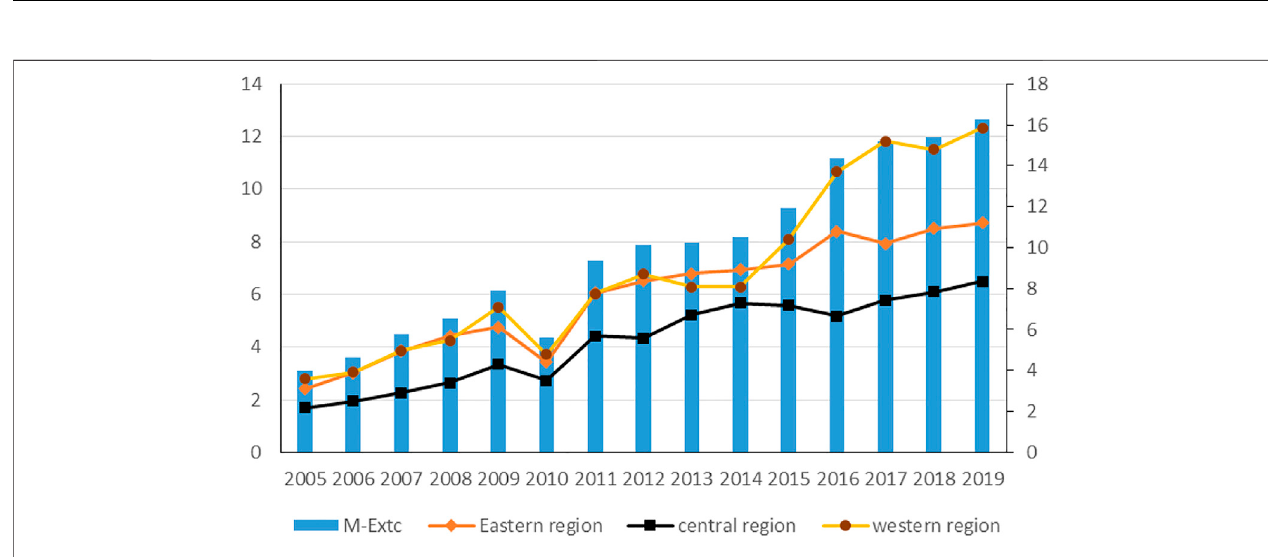
FIGURE 1 | Regional distribution of GIC in china (2005 – 2019) (unit: each). Data source: Patent Search Platform of State Intellectual Property Of fi ce.